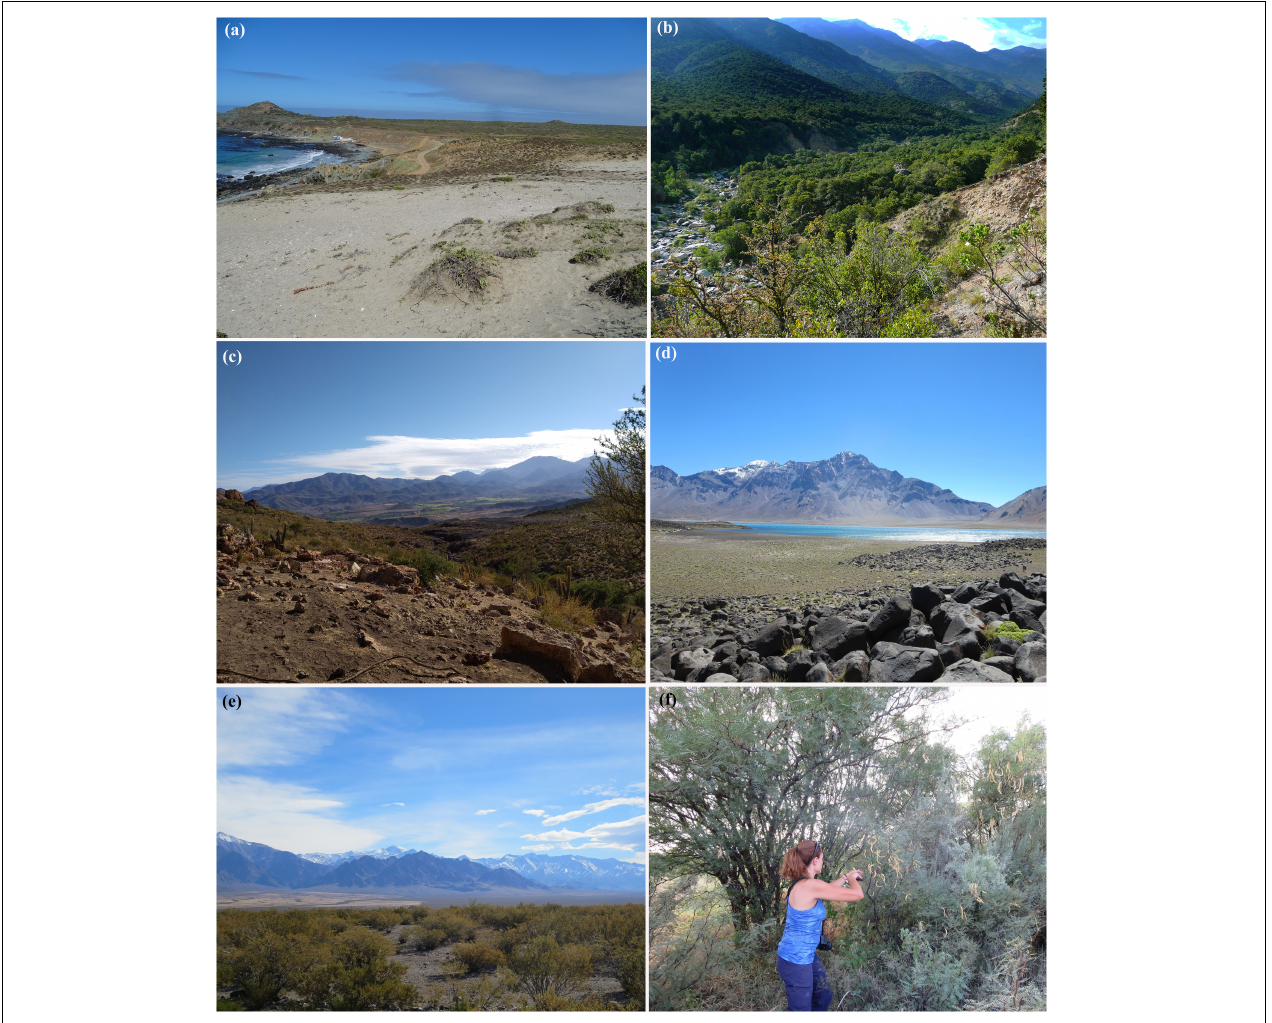
FIGURE 3 | Main regions incorporated in the Southern Andean Transect. Key : (a) Bahía La Cachina, Pacific Coast (Chile). (b) El Manzano, Western Cordillera Principal (Chile). (c) Cogotí, Western Cordillera Principal (Chile). (d) Laguna del Diamante, Eastern Principal Cordillera (Argentina). (e) Uspallata Valley, transition between Frontal Cordillera and Precordillera (Argentina). (f) Corsemar, Active Foreland (Argentina).